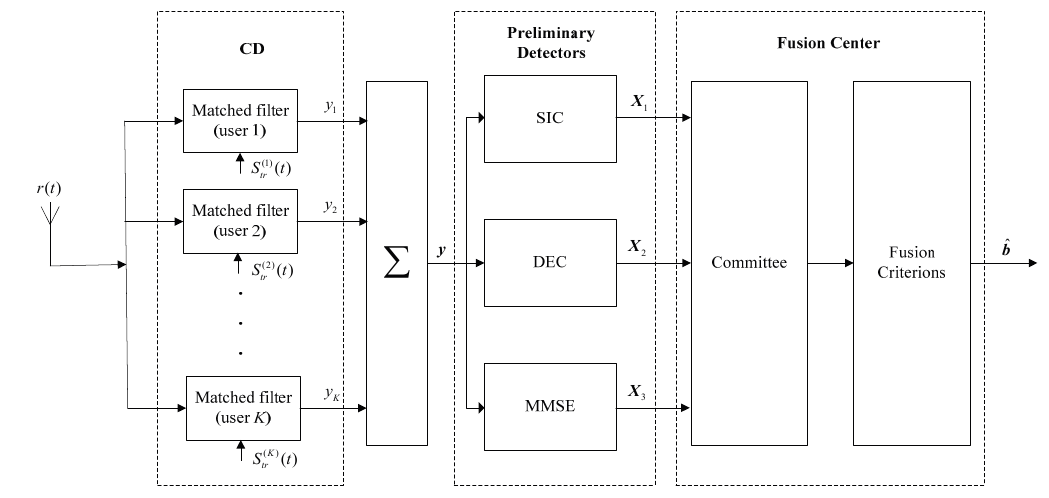
Figure 1. The structure of decision-level fusion based MUD system model.